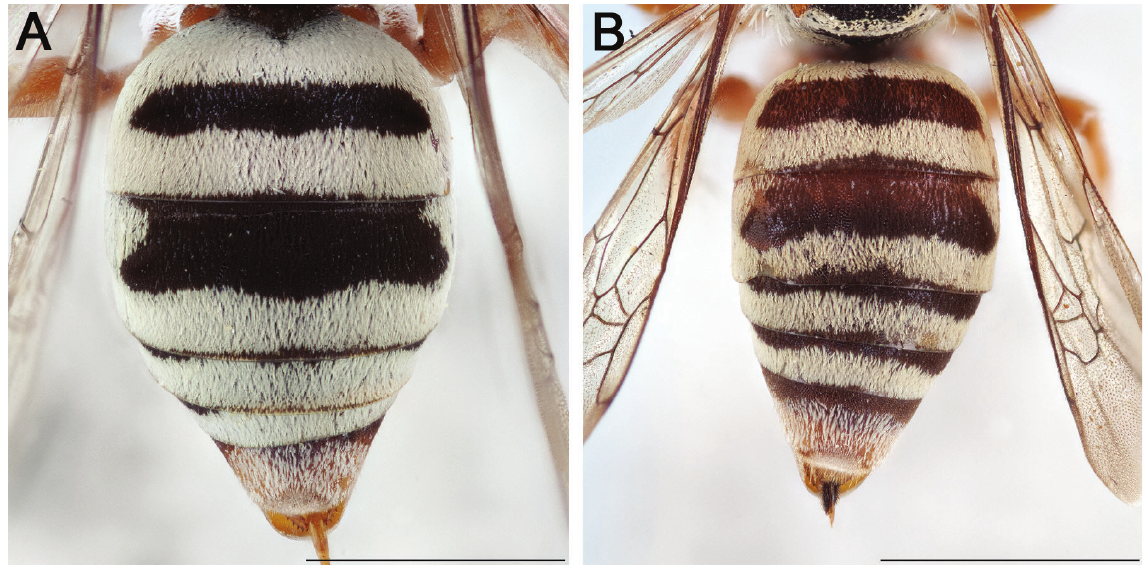
Fig. 25. Metasoma of female, dorsal view. A . E. novomexicanus Cockerell, 1912. B . E. basili Onuferko, 2018, paratype. Scale bars = 2 mm.